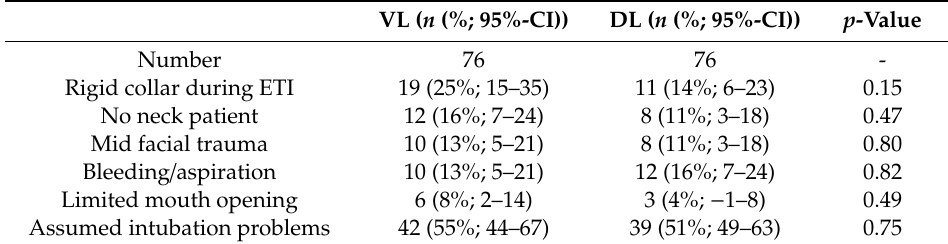
Table2. Comparisonofvideolaryngoscopy(VL)andlaryngoscopy(DL)ofpossibleintubationproblems.